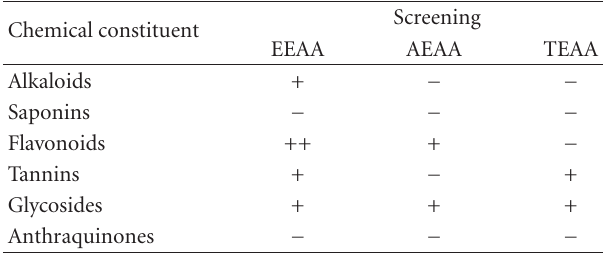
Table 5: Phytochemical screening of the extracts from A. Annua . Chemical constituent